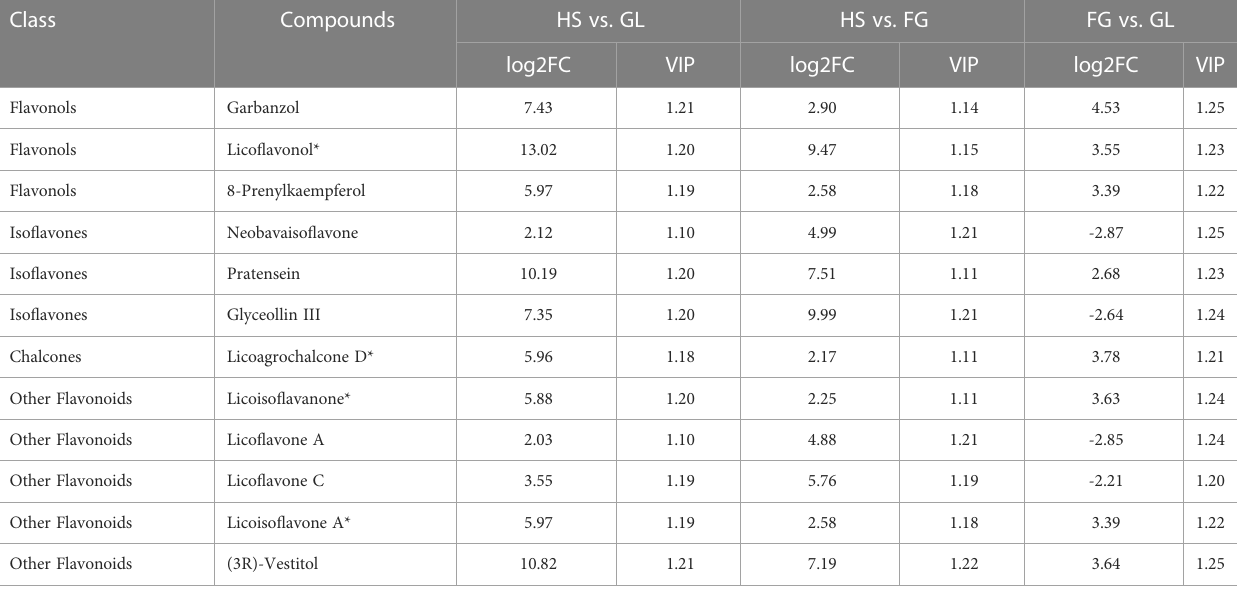
TABLE 1 Differentially accumulated compounds among the three P. thomsonii